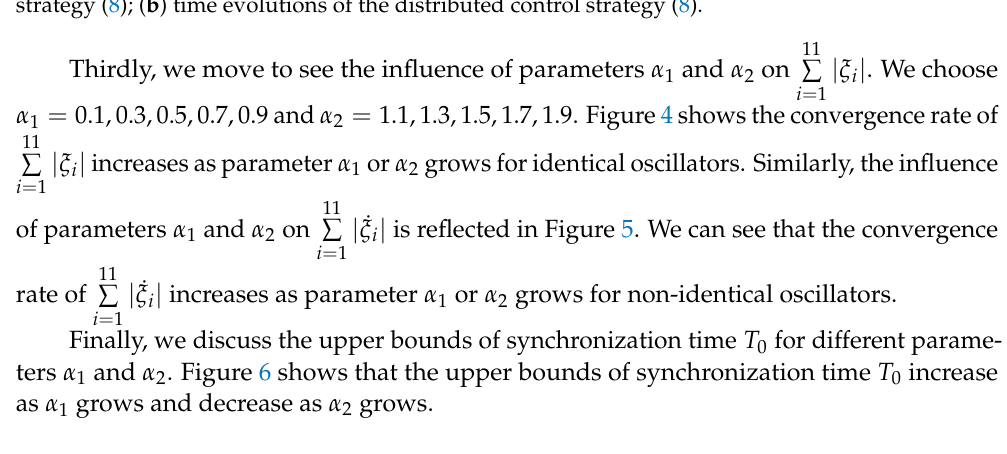
Figure 3. ( a ) Timeevolutions of frequencies differences ˙ θ i - ˙ θ 0 ( i ∈ I ) under the distributed control strategy (8); ( b ) time evolutions of the distributed control strategy